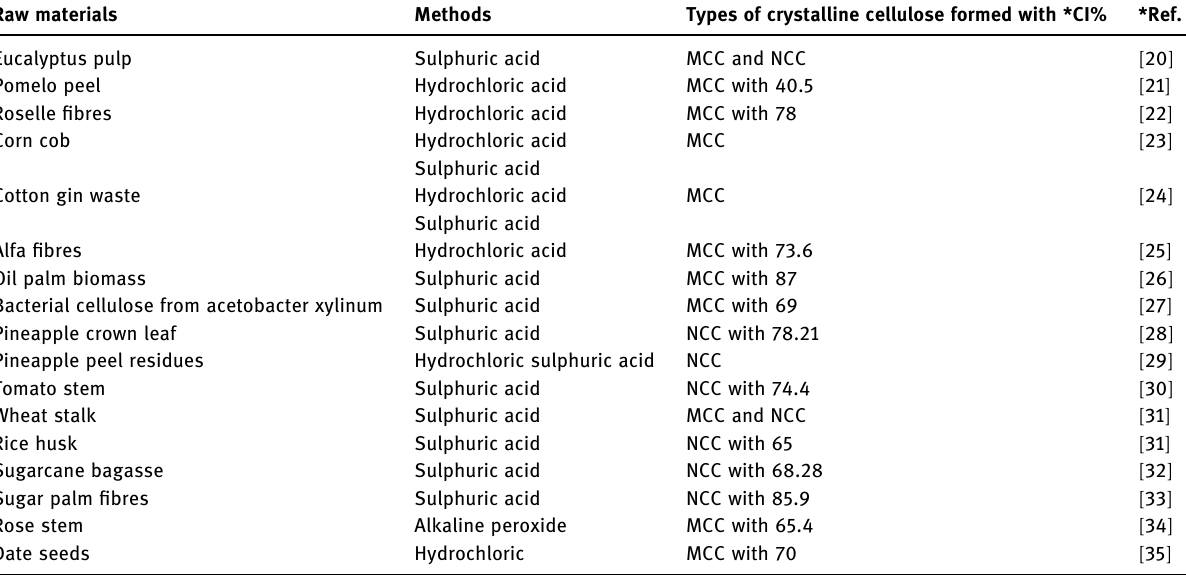
Table 1: Essential sources of lignocellulosic biomass for crystalline cellulose production Raw materials Methods